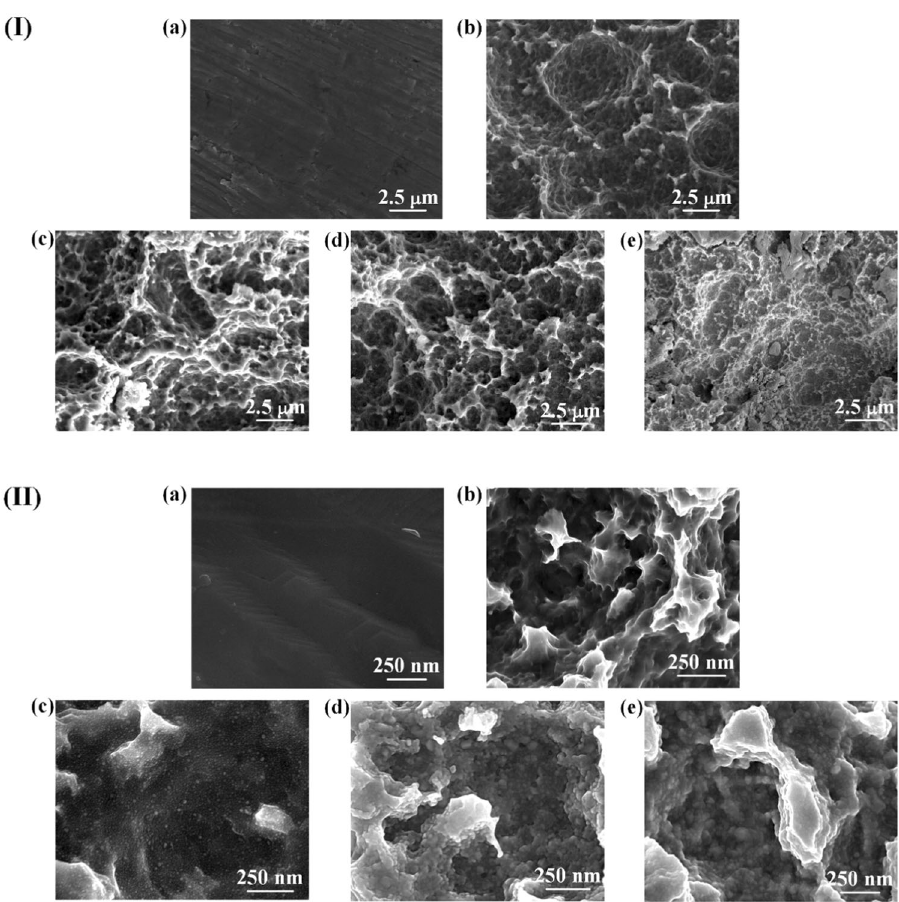
Fig. 1 SEM images with the magni fi cations of (I) ×10,000 and (II) ×80,000 for the samples of ( a ) PT, ( b ) SLA, ( c ) SLA-Ag- I, ( d ) SLA-Ag-II, and ( e ) SLA- Ag-III. Pictures with a low magni fi cation (×10,000) show the overall microscale topography, while those with a high magni fi cation